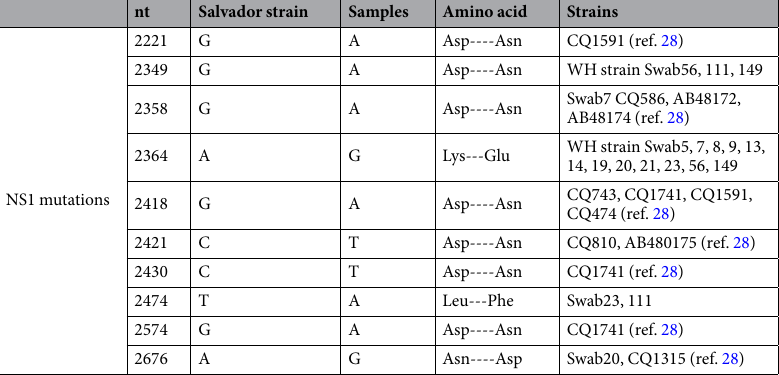
Table 1. NS1 mutations from clinical samples or reported